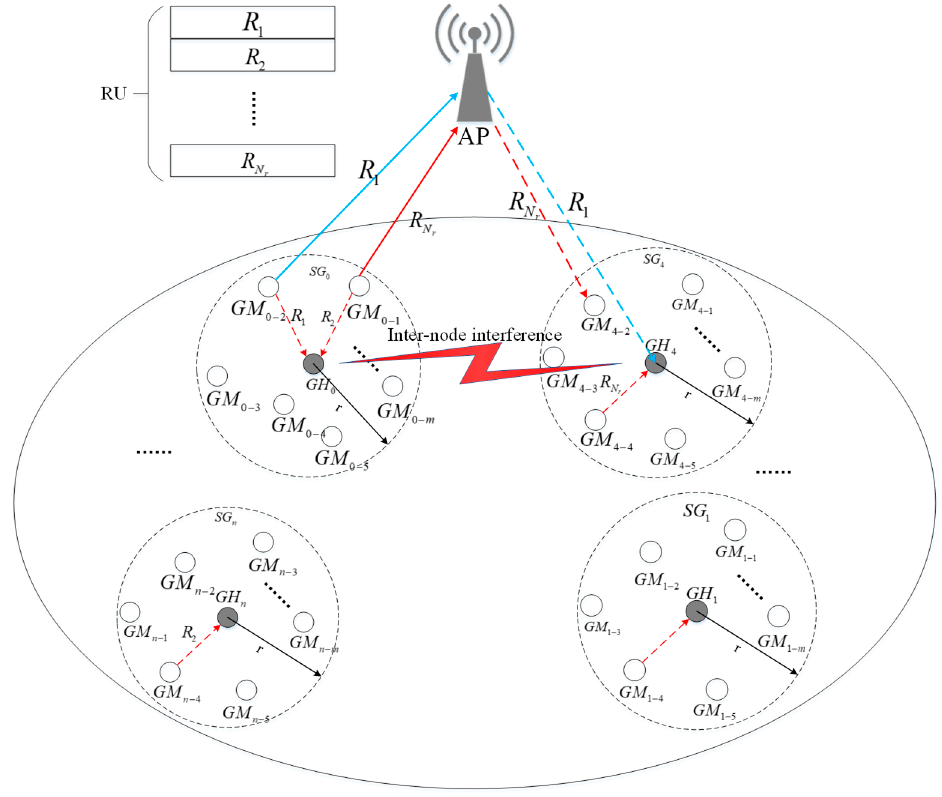
Figure 1. Full duplex communication network scenario under high-density deployment.